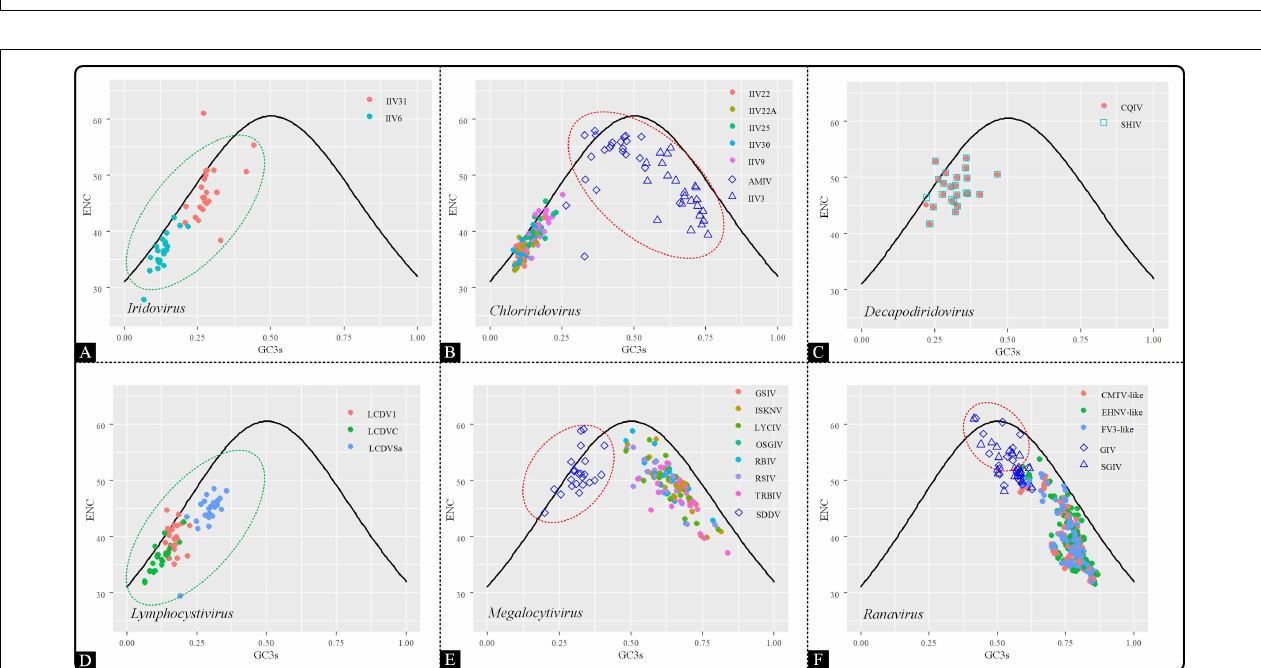
FIGURE 4 | Correspondence analysis of the synonymous codon usage in the Iridoviridae family. The analysis was based on the RSCU value of the 59 synonymous codons. Green circles suggest a high dispersion degree among the points inside the circle, while red circles indicate that points inside the circle have a high degree of dispersion as compared to those outside the circle. (A) Iridovirus , (B) Chloriridovirus , (C) Decapodiridovirus , (D) Lymphocystivirus , (E) Megalocytivirus , and (F) Ranavirus.